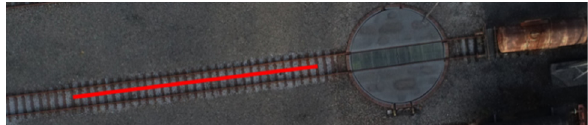
Figure 5. Presentation of the height profiles of the different point clouds in the track axis - profile position in the photo (top), point cloud profiles (bottom): P4D JPG80 (pink), P4D TIF (brown), PS JPG80 (green) and PS TIF (blue)